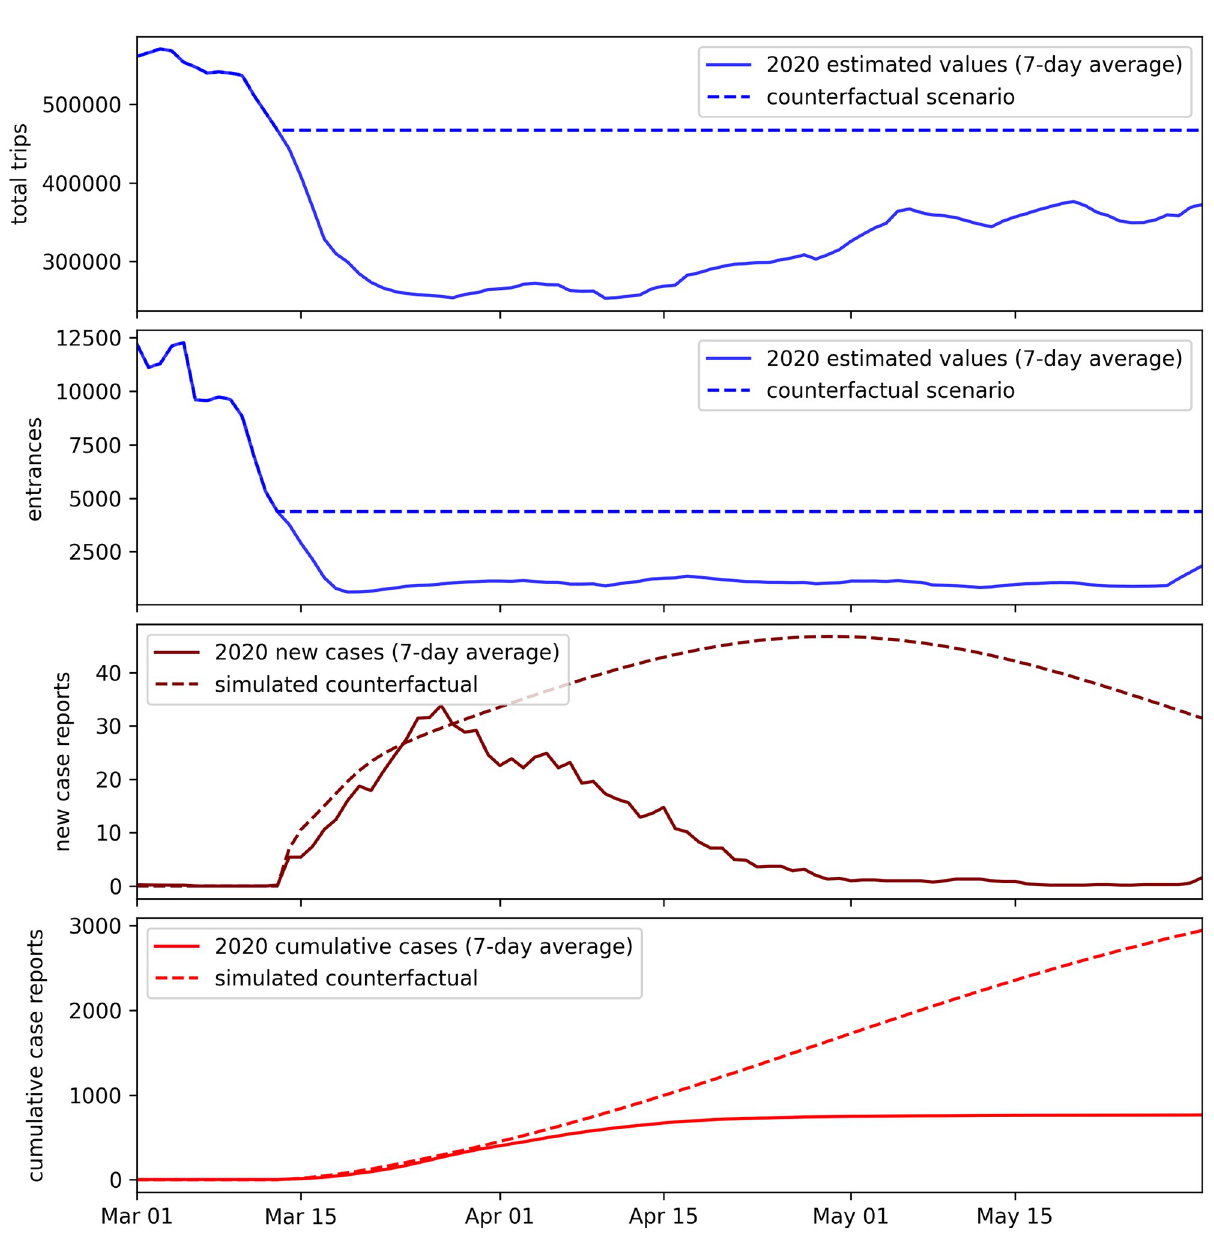
Fig 5. Counterfactual results. Top: Hypothetical total trips and entrances metrics that are used to simulate reported cases for a counterfactual scenario where mobility and border restrictions had not been put in place. Bottom: Simulated reported cases for such a counterfactual scenario, versus the actual reported cases that occurred in the true